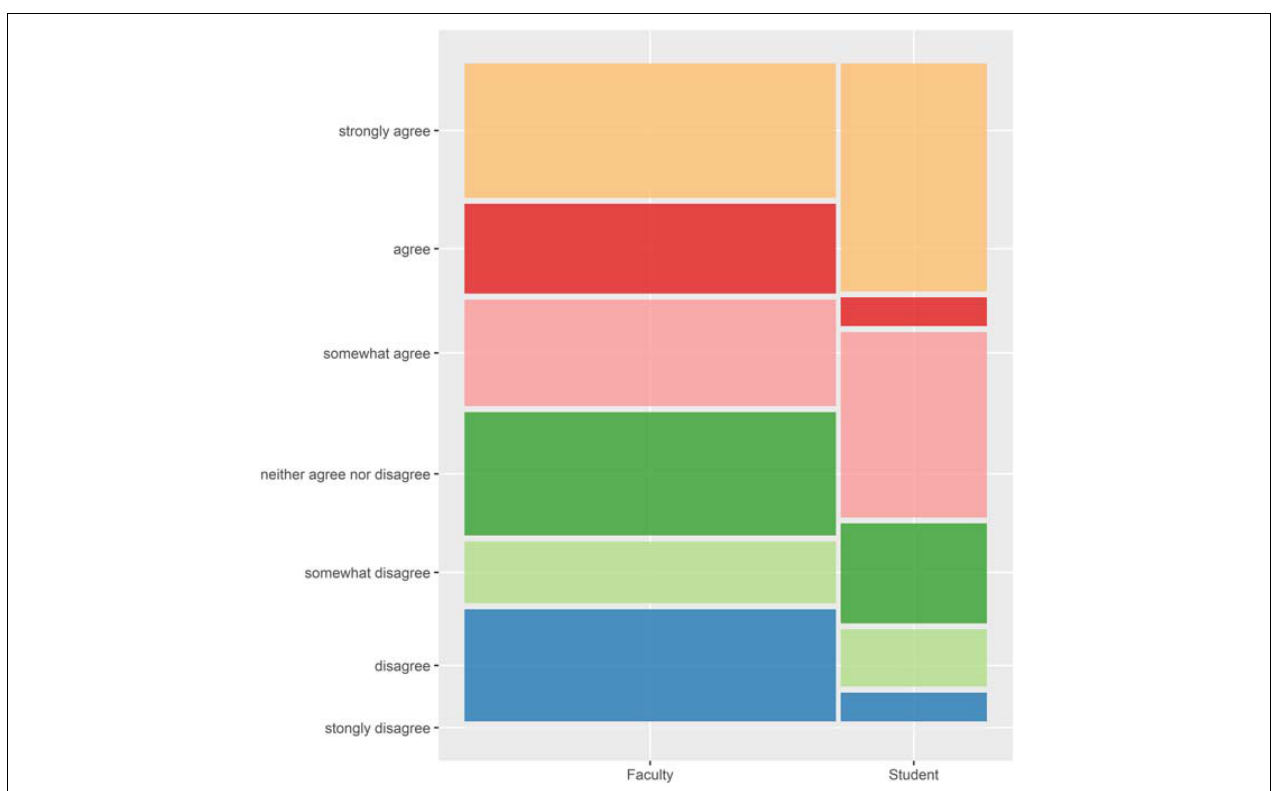
FIGURE 2 | Faculty and student responses to: Proctoring software in online tests is an invasion of student privacy.